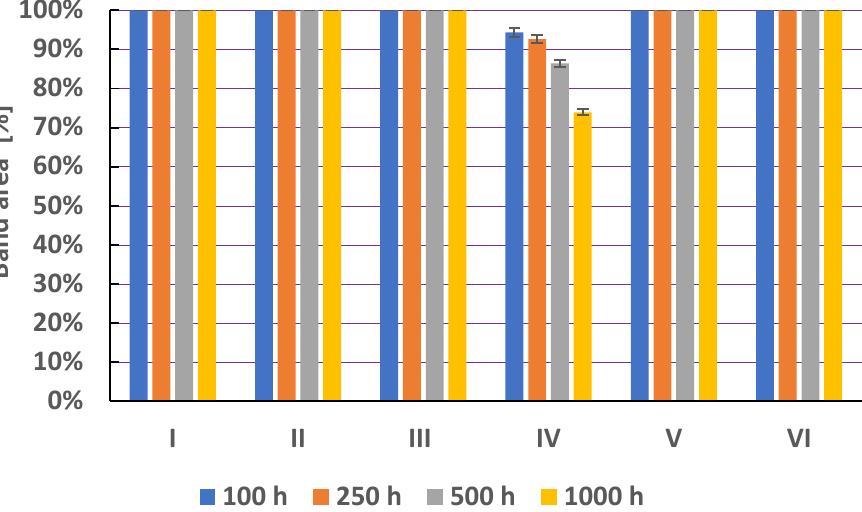
Figure 6. The comparison of means area ( ± SD) (in %) of chromatographic bands obtained from metronidazole (M) in different solvents (I—in water at pH = 2.62; II—in water at pH = 5.56; III—in water at pH = 8.21; IV—in hydrogen peroxide (3%); V—in physiological salt (0.9% NaCl); and VI—in methanol) which were heated at 40 °C during 100, 250, 500, and 1000 h, where SD is the standard deviation.